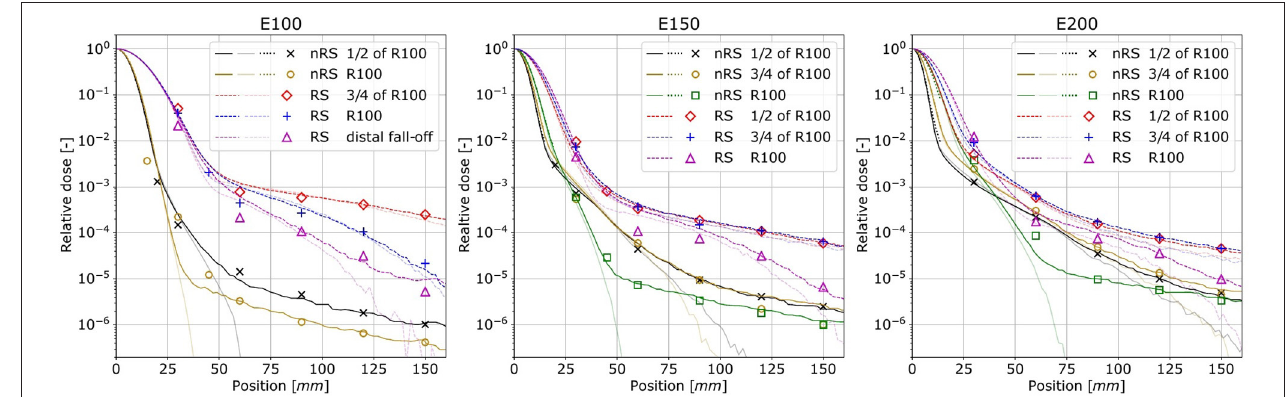
FIGURE 6 | Lateral beam dose profiles measured in water at different depths for three beam nominal energies. Points correspond to M INI P IX T IMEPIX measurement results, dotted lines are results of measured with LYNX detector, whereas solid and dashed lines are the GATE /Geant4 data without (nRS) and with RS, respectively. Corresponding transparent lines presents FRED simulations result.